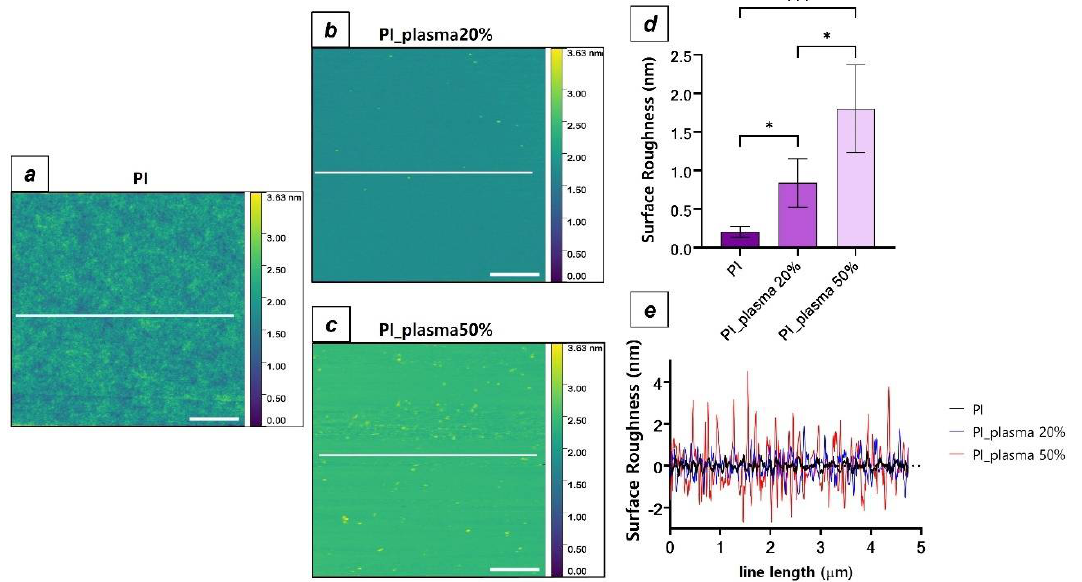
Figure 2. Surface roughness analysis of PI. AFM scan of untreated PI ( a ), PI_plasma20% ( b ), and PI_plasma50% ( c ). ( d ) Average surface roughness calculated for untreated and plasma-treated PI. ( e ) Plot of surface roughness profile of PI substrates relative to the white line drawn in each AFM scan. Scale bars are 1 μm.